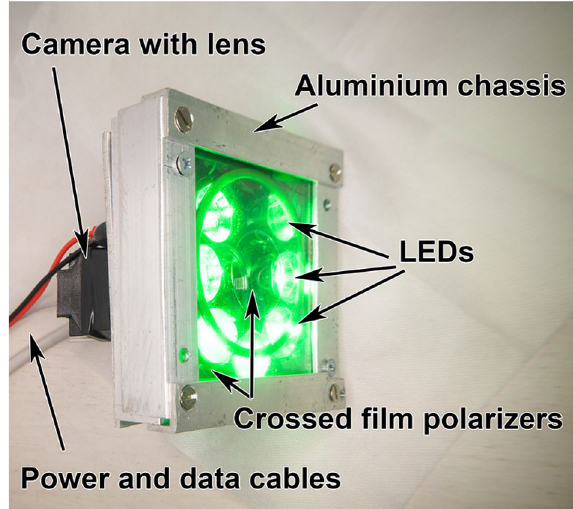
Figure 3. Custom-made iPPG system used in the experimental